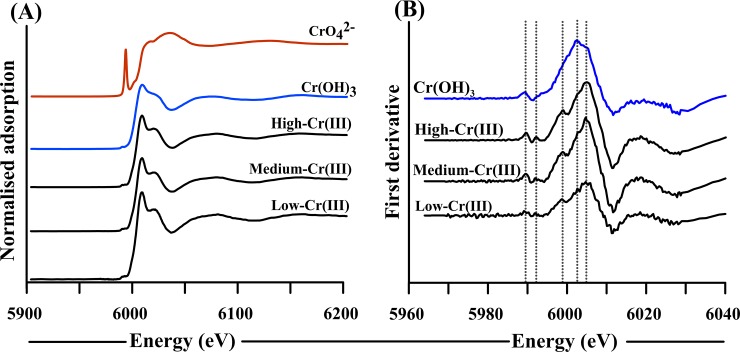
Chromium K-edge XANES spectra of (A) Cr(III)-substituted schwertmannite, Cr(OH)3
and CrO42-
and (B) corresponding first derivative spectra. The vertical dotted lines in (B) highlight features which are attributable to Cr(III) for Fe(III) substitution based on Tang et al. [37].